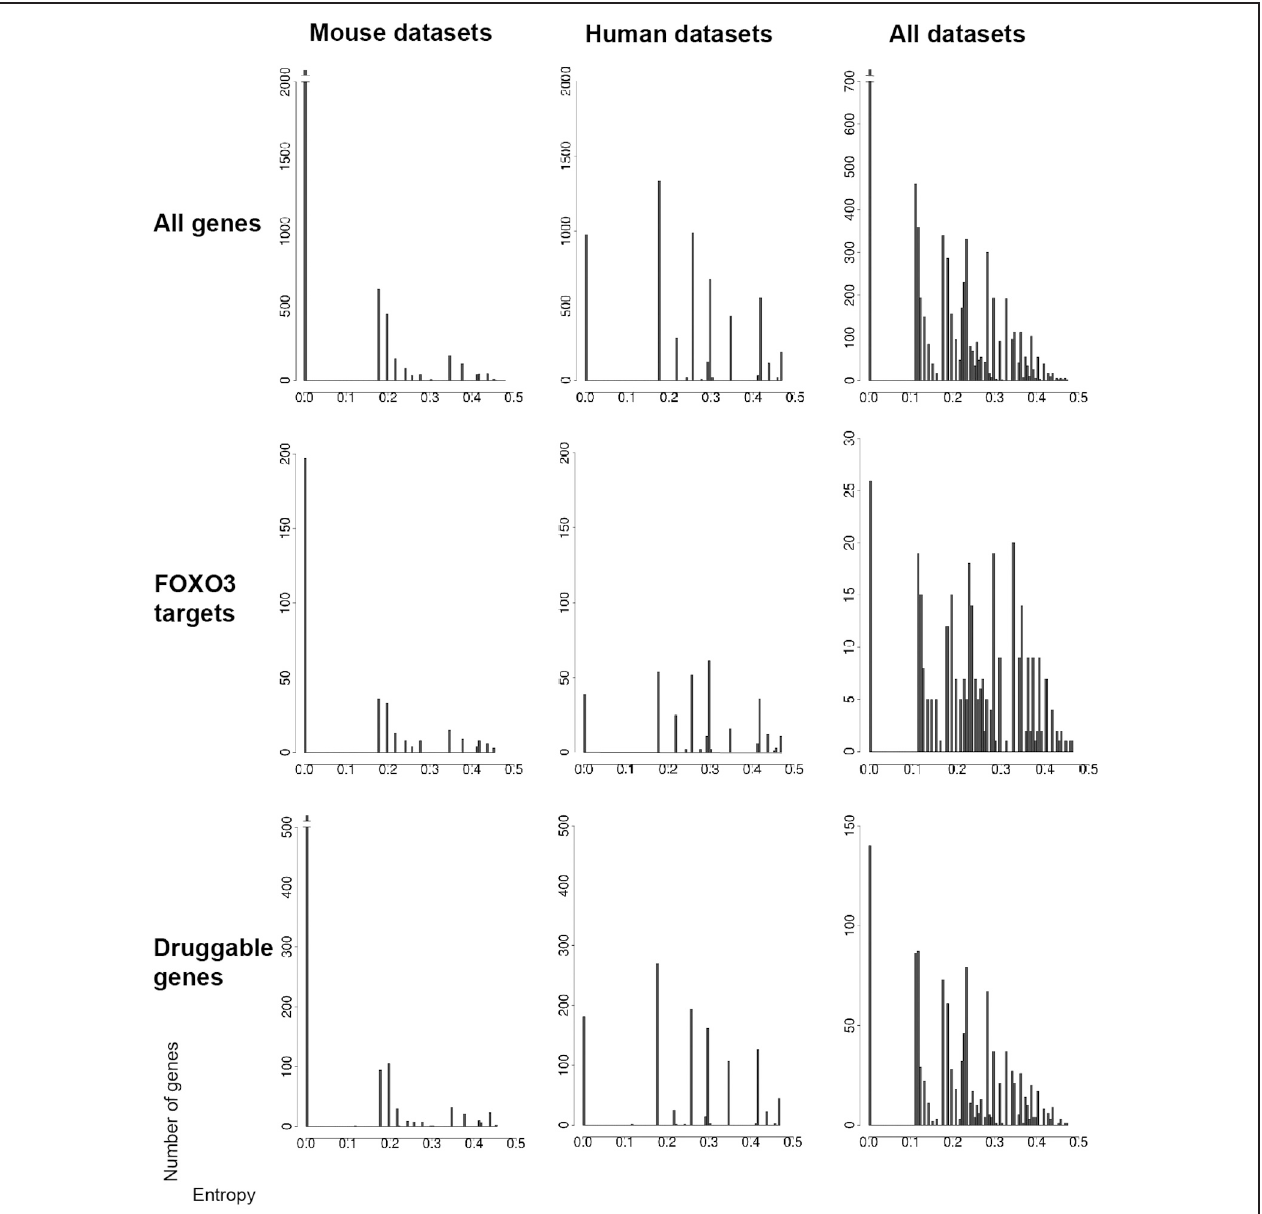
gene-interaction data and (2) further instructed by at least six conditions in the mouse, six conditions in humans and 11 conditions in both species. The maximally achievable entropy value in these analyzes is 0.5. The corresponding gene lists are shown in Tables S3–5 as organized by species or across species and as shown for all numbers of instructive